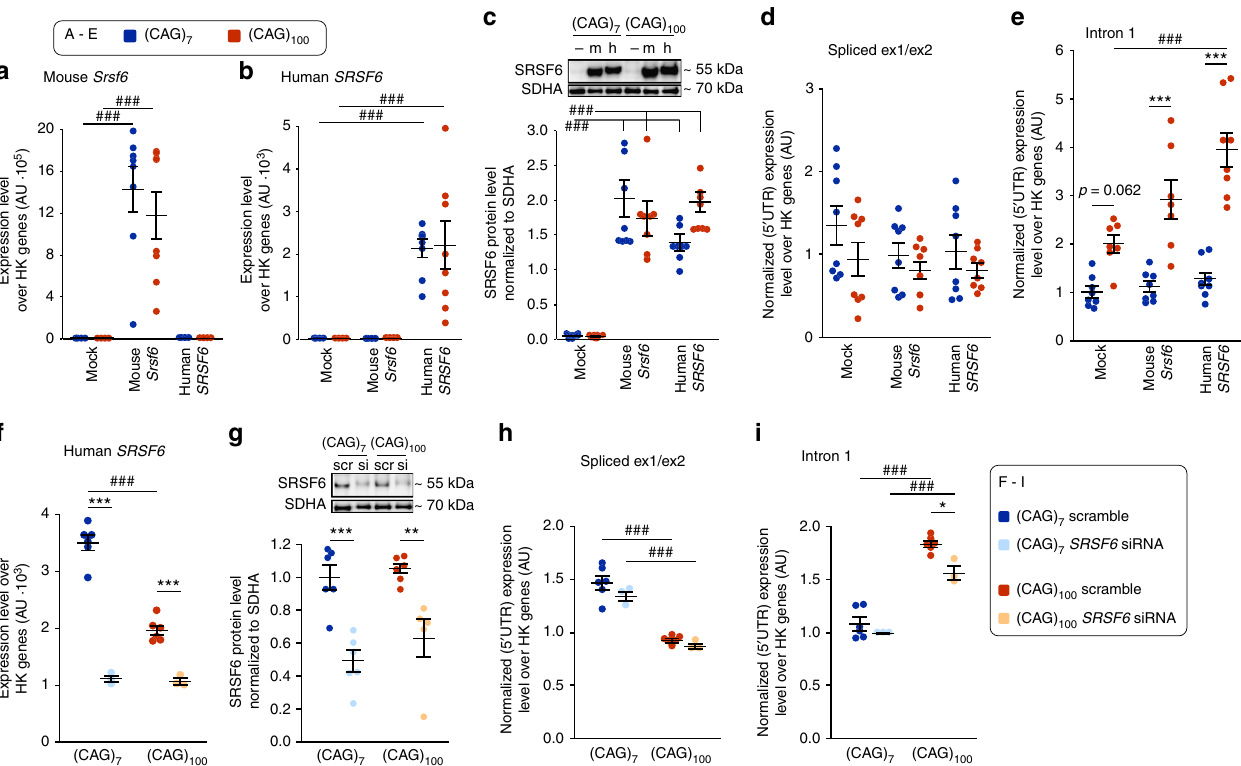
Fig. 3 SRSF6 levels modulate incomplete splicing of Htt . a – e Overexpression of SRSF6 increases the amount of incomplete splicing. Mouse Srsf6 ( a ) and human SRSF6 ( b ), respectively, were over-expressed to the same extent in the CAG 7 and CAG 100 cell lines. c Western blot data con fi rmed the over- expression of mouse and human SRSF6 for both CAG repeat lengths. - = mock; m = mouse SRSF6; h = human SRSF6. Uncropped blots can be found in Supplementary Fig. 8A. d Spliced exon 1 – exon 2 transcripts were not signi fi cantly changed due to the overexpression of mouse or human SRSF6 . e Intron 1 containing transcripts were increased to statistically signi fi cantly levels when human SRSF6 was over-expressed. Individual data points and the mean ± s.e. m. are shown. n = 8 independent experiments/CAG-length; two-way ANOVA with Tukey post hoc. Effect of SRSF6 overexpression for a given CAG-length: ### p < 0.001. Effects due to CAG-length for a given treatment: *** p < 0.001. f – i Knock-down of SRSF6 by siRNA treatment (s12740, ThermoFisher) decreased the amount of incomplete splicing. SRSF6 levels were decreased by siRNA treatment on transcript ( f ) and protein ( g ) levels for both CAG repeat lengths. scr = scramble; si = siRNA treatment. Uncropped blots can be found in Supplementary Fig. 8B. h Spliced exon 1 – exon 2 transcripts were not changed due to the knock-down of SRSF6 . i There was a statistically signi fi cant reduction in the amount of incompletely spliced minigene in the CAG 100 line. Individual data points and the mean ± s.e.m. are shown. n = 3 – 6 independent experiments/CAG-length; two-way ANOVA with Tukey post-hoc. Treatment for a given CAG-length: * p < 0.05, ** p < 0.01, *** p < 0.001. Treatment x CAG-length ### p < (CAG) 23 or (CAG) 100 repeat into unrelated SDHA or SPP1